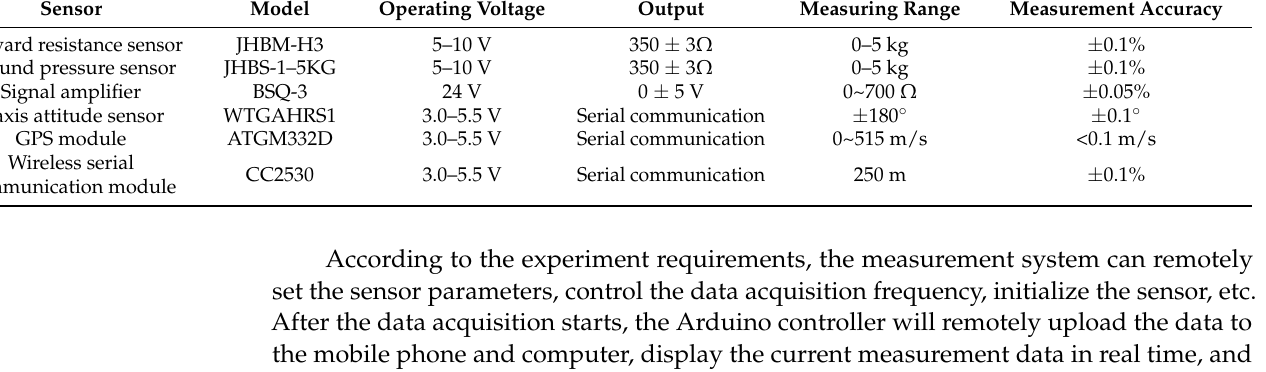
Figure 3. Flow chart of ground pressure measurement system. Table 1. Brief information about components used and measurement instrumentations.